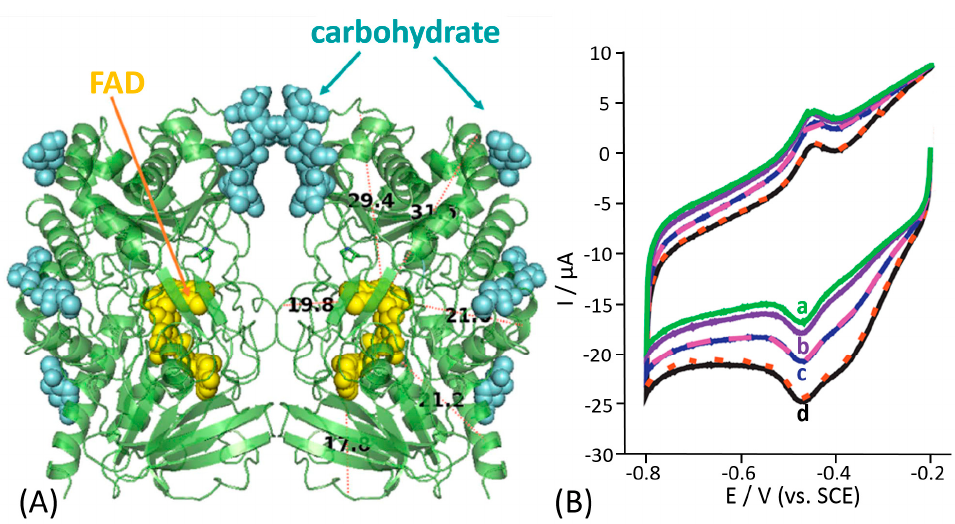
Figure 8. ( A ) Representation of the secondary structure of GOx. The image was obtained with PyMol software, PyMol visualizations are based on the crystal structure of GOx from Aspergillus niger , PDB code 1gal http://www.rcsb.org/pdb/explore/explore.do?structureId=1GAL. ( B ) Cyclic voltammograms showing oxygen reduction on a glassy carbon electrode modified with multi-walled carbon nanotubes and loaded with GOx: (a) in the absence of glucose, and in the presence of (b) 2 mM, (c) 4 mM and (d) 8 mM glucose. The experiment was performed in 0.1 M phosphate buffer, pH 6.8, in the presence of oxygen (in equilibrium with air) with the potential scan rate of 60 mV s − 1 . Note that this and similar cyclic voltammograms were erroneously reported as the proof of the DET with GOx. (The figure is adopted from ref. 98 with permission.).